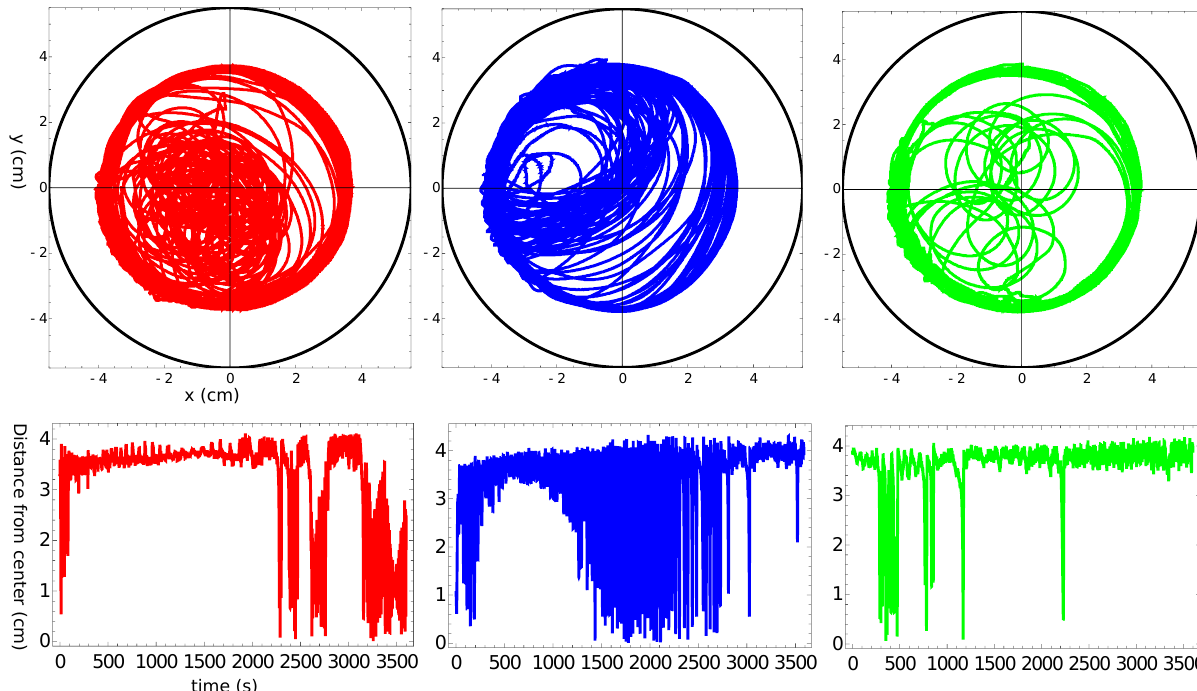
Figure 2. The upper three figures show the trajectories of a 4 mm pill made of 95% camphene and 5% polypropylene in a Petri dish with an 11 cm diameter. The black circle indicates the location of the dish wall. The distance between the pill center and the dish center as a function of time is plotted in the figures located below the corresponding